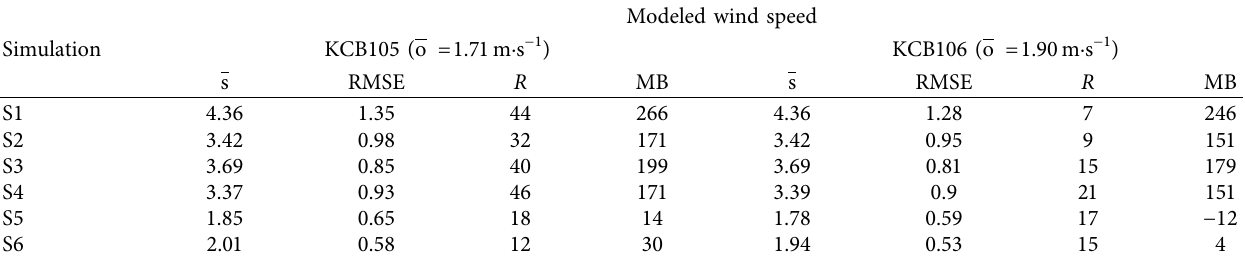
Table 9: Wind speed statistics over KCB105 and